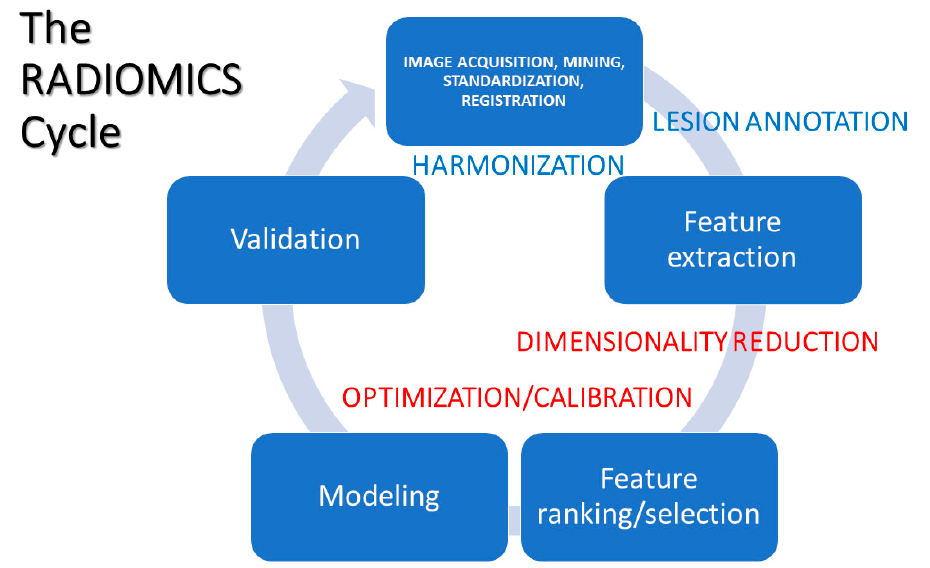
Figure 1. Typical steps in the radiomics (RAD) process.